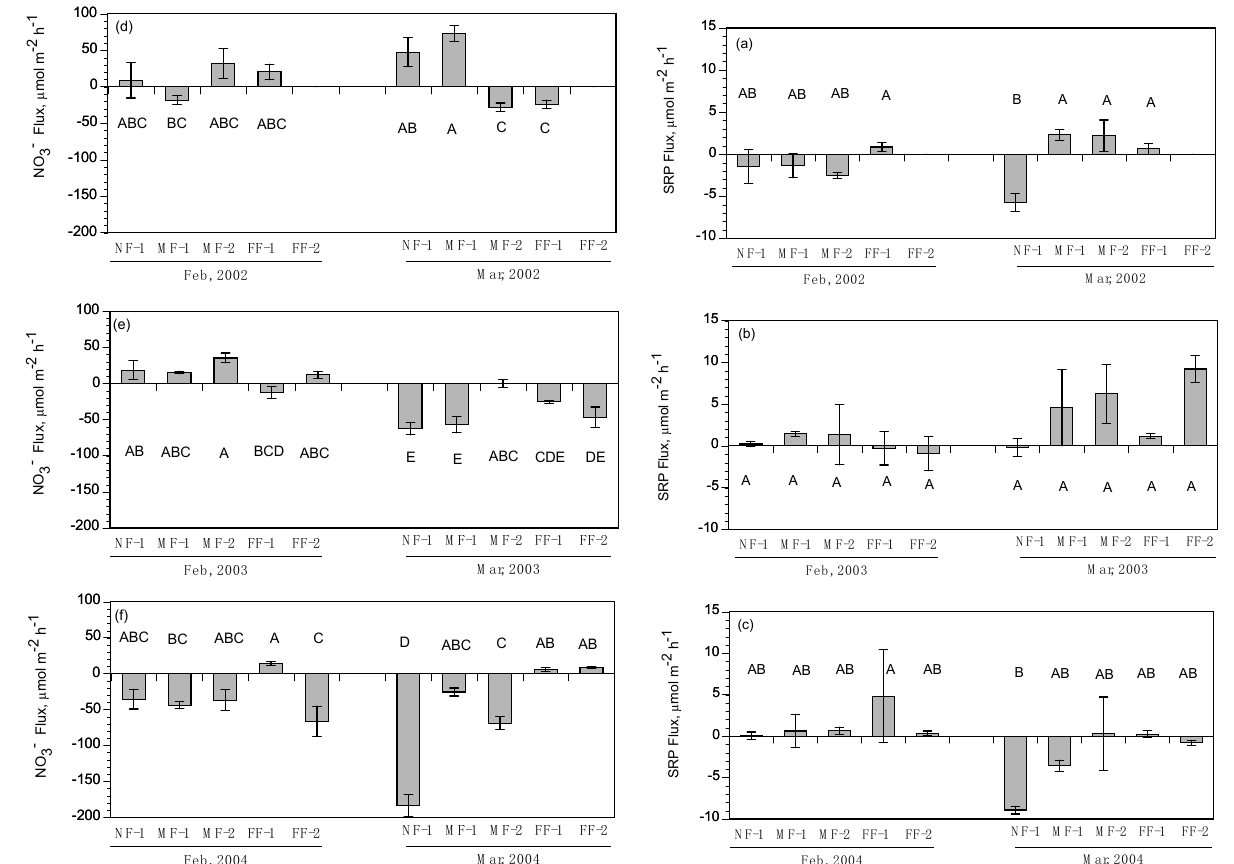
Figure 5. Subtidal benthic fluxes of soluble reactive phosphorus (SRP, a – c ) and nitrate (NO 3 − , d – f ) at five stations in Breton Sound during spring diversion pulses (February and March) in 2002 ( a , b ), 2003 ( b , e ), and 2004 ( c , f ). (NF = Near-field, MF = Mid-field, FF = Far-field).